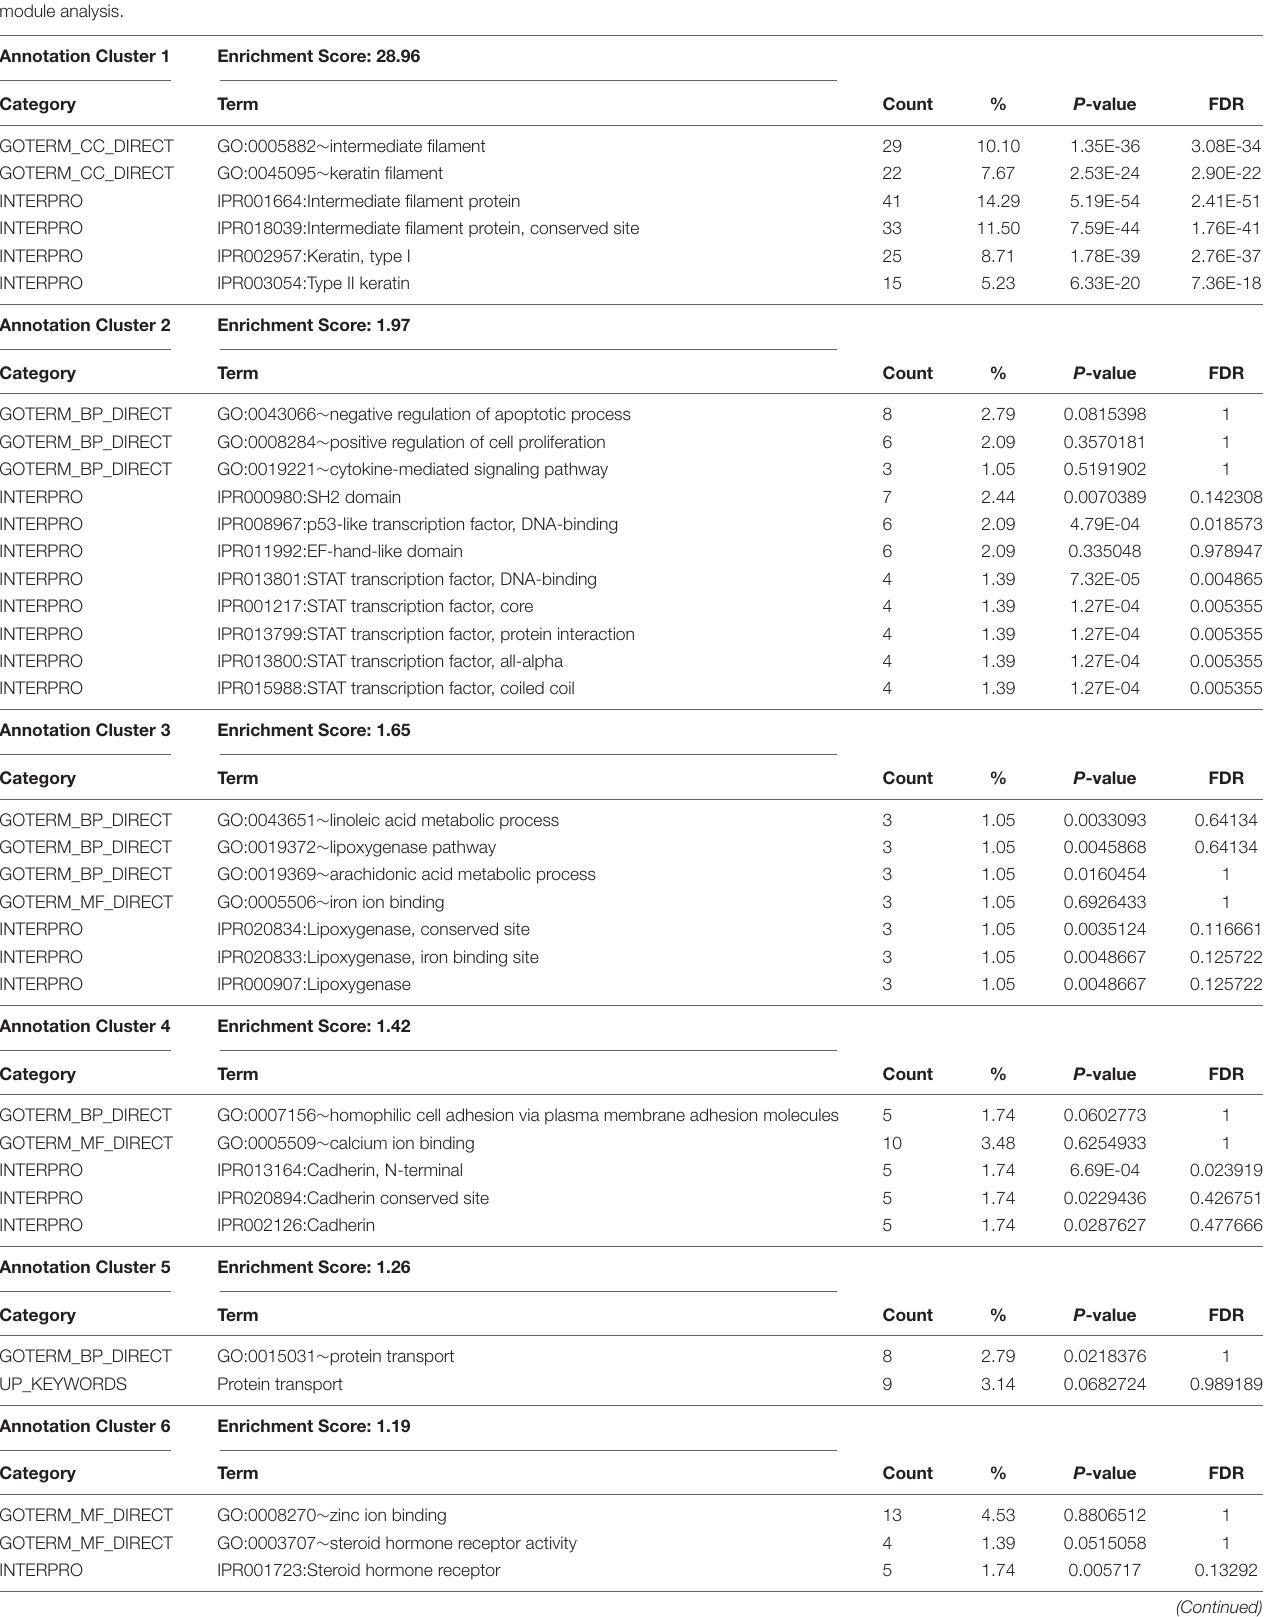
TABLE 5 | Top pathways enriched in pleiotropic regions for carcass quality, sensory meat quality, and visual meat quality traits from the DAVID functional annotation module analysis. Annotation Cluster